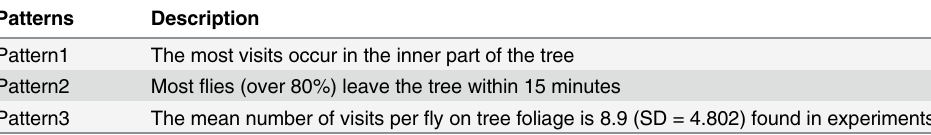
Table 2. The three observed patterns used for model output